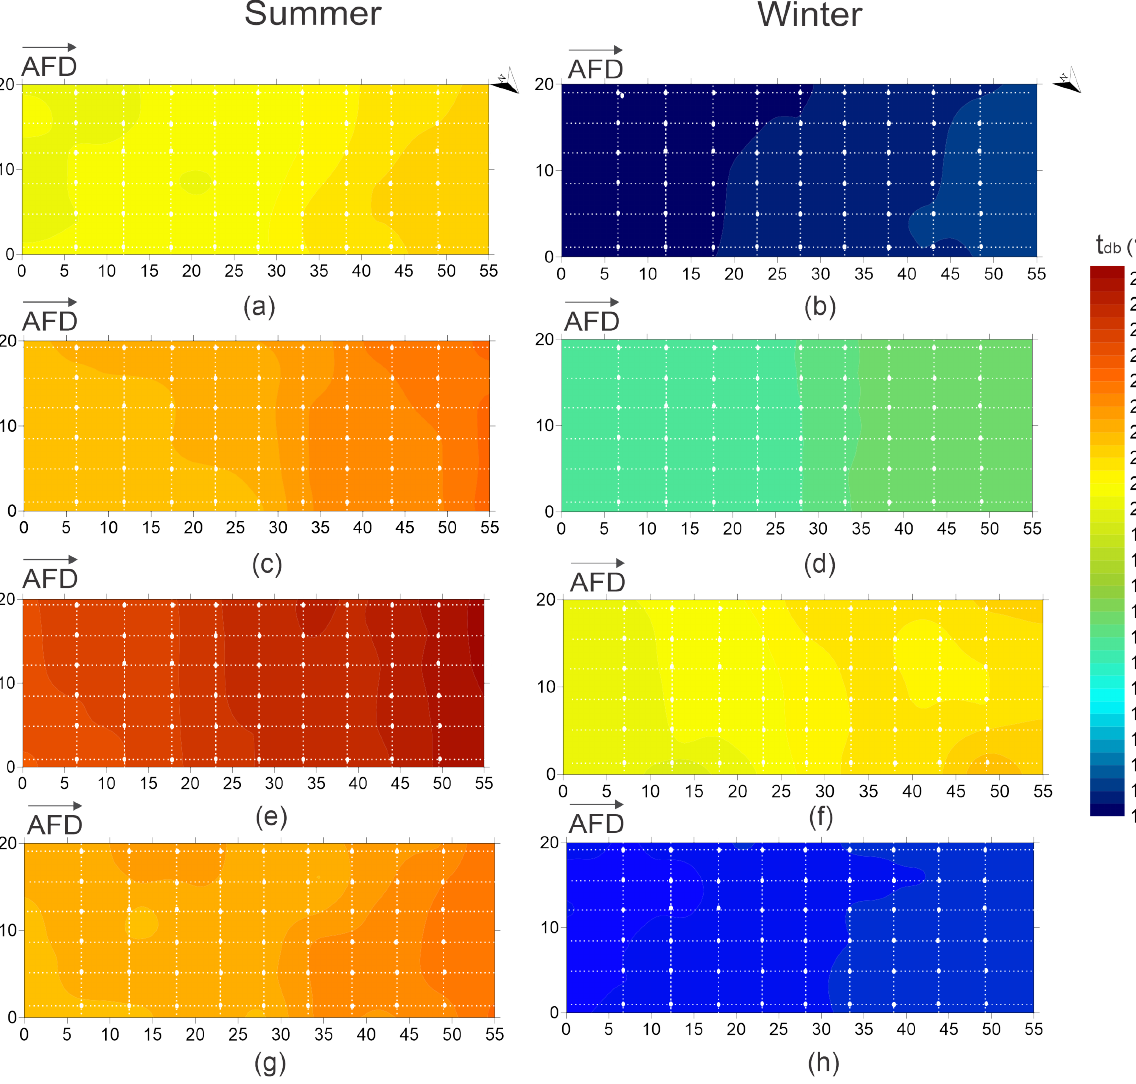
Figure 5. Spatial distribution of the air dry-bulb temperature variable (°C), during the dawn (00:00a.m. to 05:00a.m.), morning (06:00a.m. to 11:00a.m.), afternoon (12:00p.m.-05:00p.m.) and night (06:00p.m. to 11:00p.m.) inside the compost bedded pack barn (CBP), during the summer and winter experimental period. *AFD – Air flow